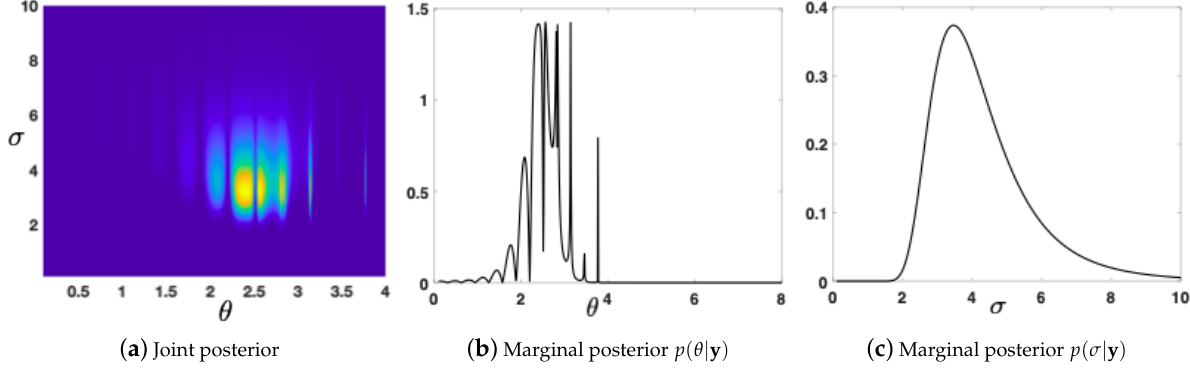
Figure 2. The bidimensional joint posterior p ( θ , σ | y ) and the two marginal posteriors p ( θ | y ) , p ( σ | y ) in Equation (11), computed by using a thin grid approximation.